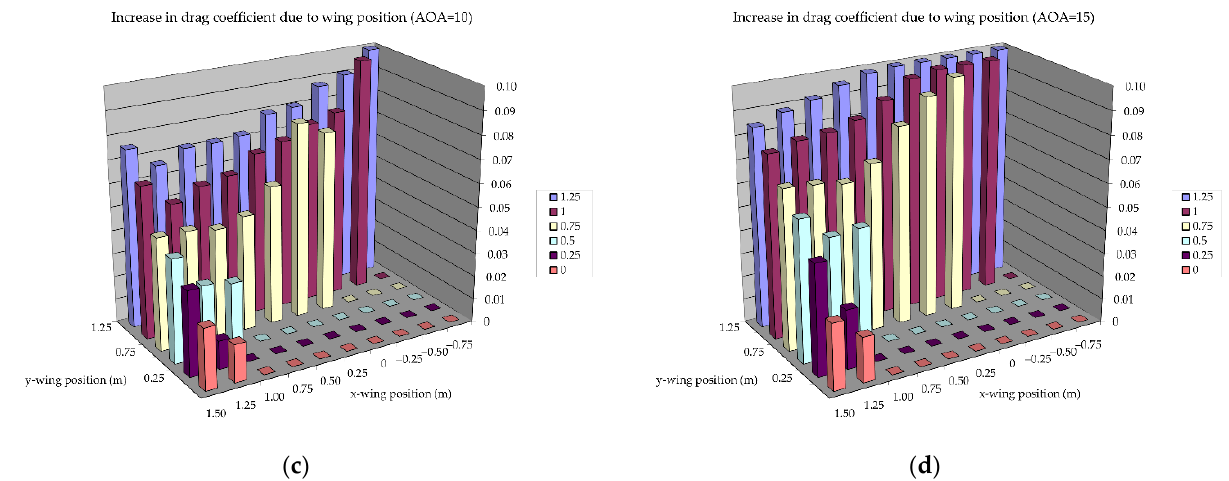
Figure 20. Increases in aerodynamic drag coefficient as a function of the angle of attack and wing position in relation to the car body: ( a ) AOA 0 degrees; ( b ) AOA 5 degrees; ( c ) AOA 10 degrees; ( d ) AOA 15 degrees.